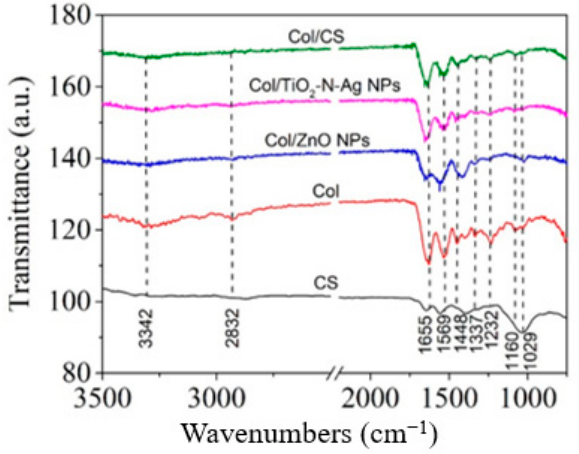
Figure 4. Normalized attenuated total reflectance (ATR)-FTIR spectra for the electrospun collagen glue loaded with antimicrobial agents.